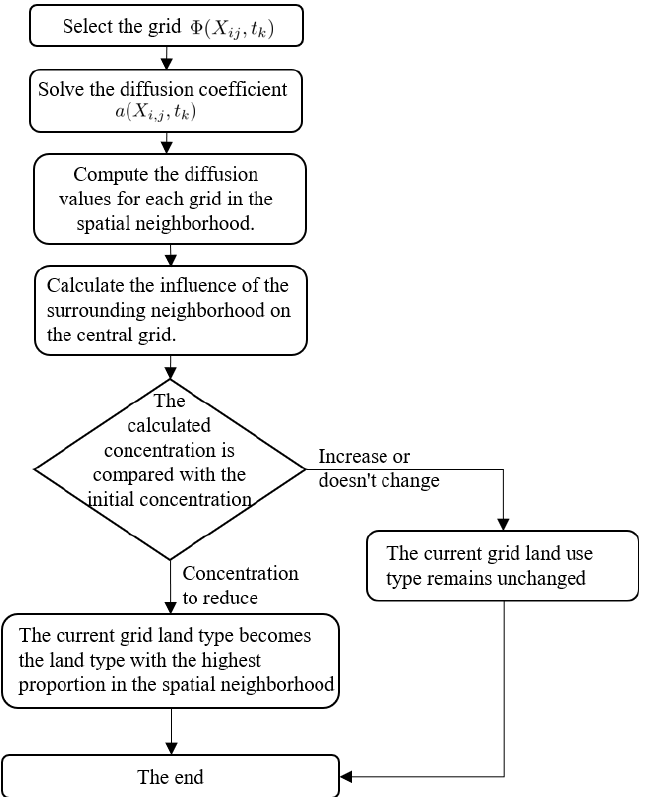
Figure 3. The flowchart for predicting the land use/land cover using the diffusion equation for all